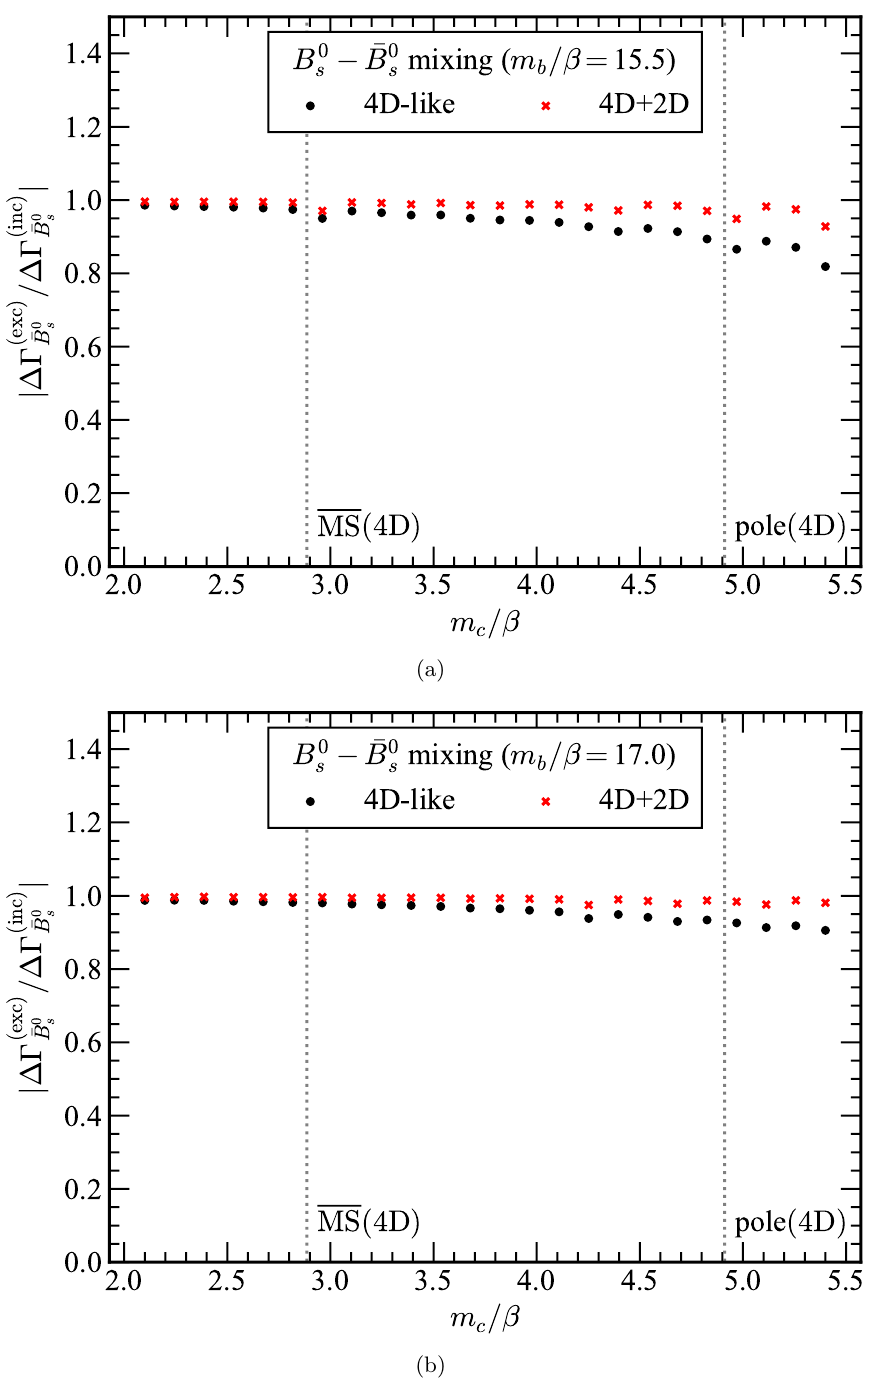
¯ mixing: (a) m − B 0 s s